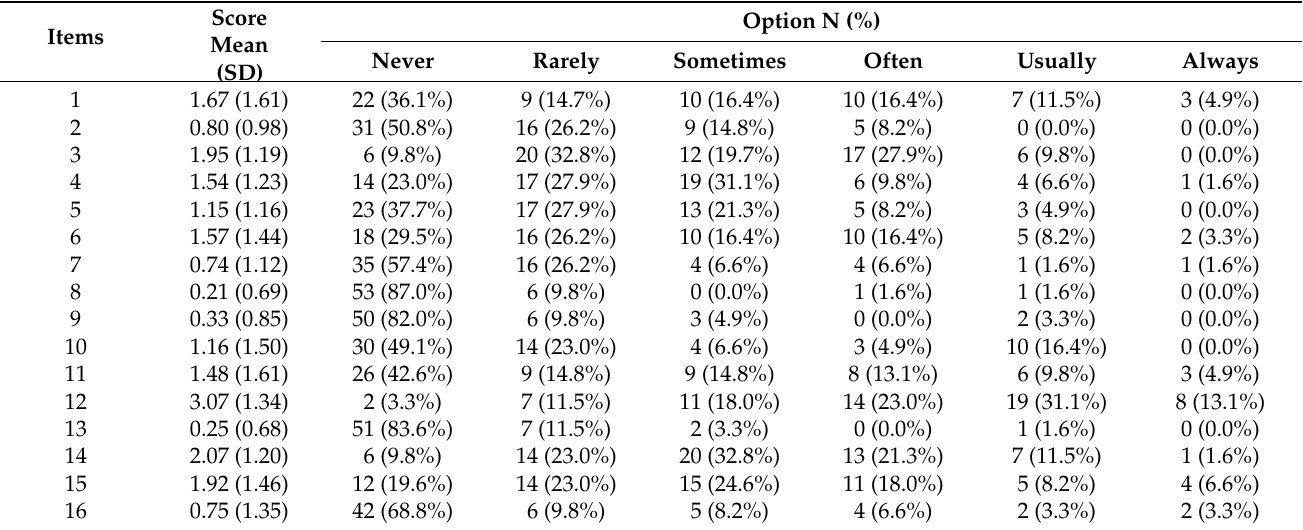
Table 4. Distribution of item scores on the C-DEPS-R among adults ( n = 61).